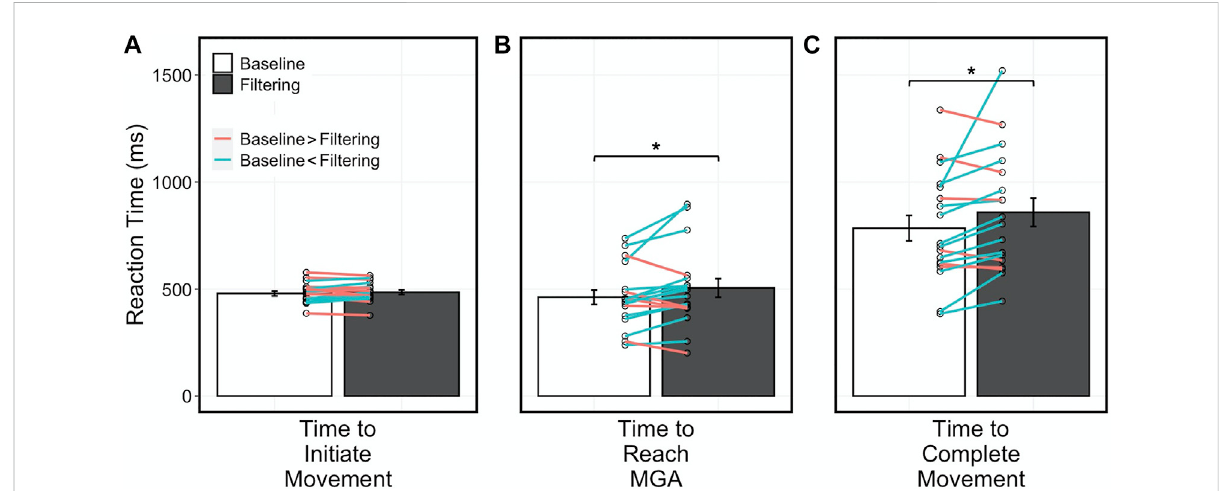
FIGURE 3 (A) Average time to initiate movement was similar between conditions (t 17 = 1.17, p = 0.260). (B, C) Average time to reach MGA t 17 = 2.17, p = 0.044) and average time to complete movement (Z 17 = 142, p = 0.012) were signi fi cantly slower in the fi ltering condition than in the baseline condition. Red lines represent individuals with RT greater in baseline condition than in fi ltering condition and blue lines represent individuals with RT greater in fi ltering condition than in baseline condition. Error bars represent standard error. p < 0.05*.